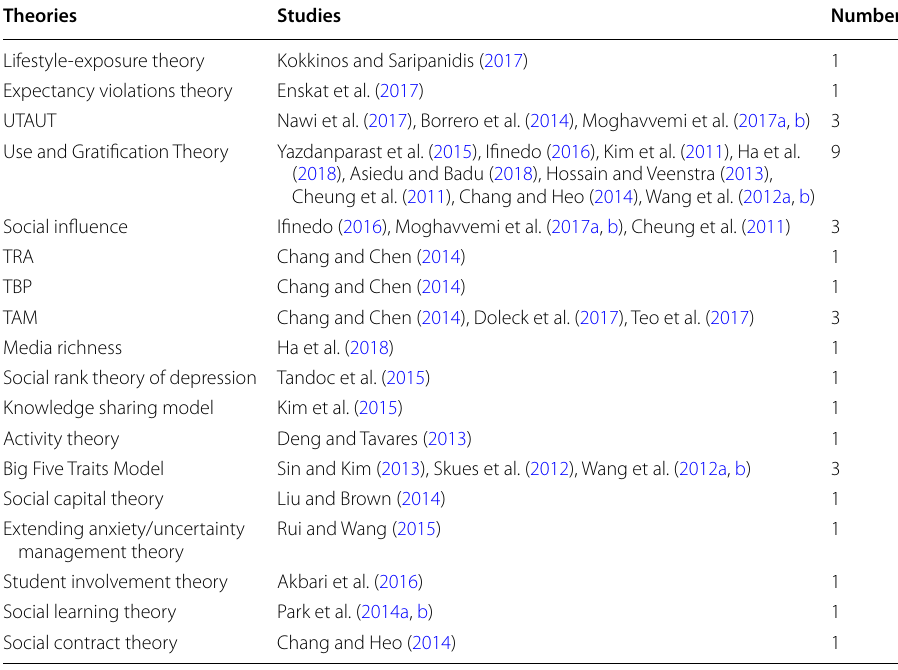
Table 3 Theoretical foundations of primary